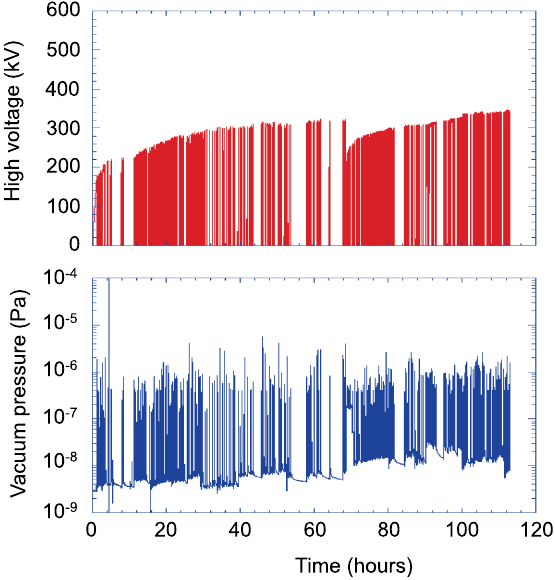
FIG. 8. High voltage (top) and vacuum pressure (bottom) as a function of time during HV conditioning in gun configuration (B), shown in Fig. 7(a).